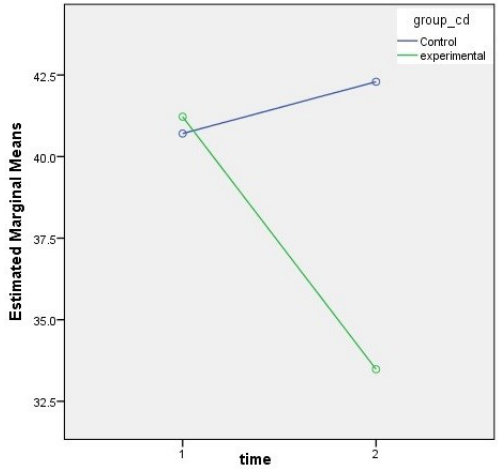
Figure 3. The estimated marginal mean obtained from data obtained from SAS questionnaire. Time 1 and 2 represents pre and post SAS results, respectively.